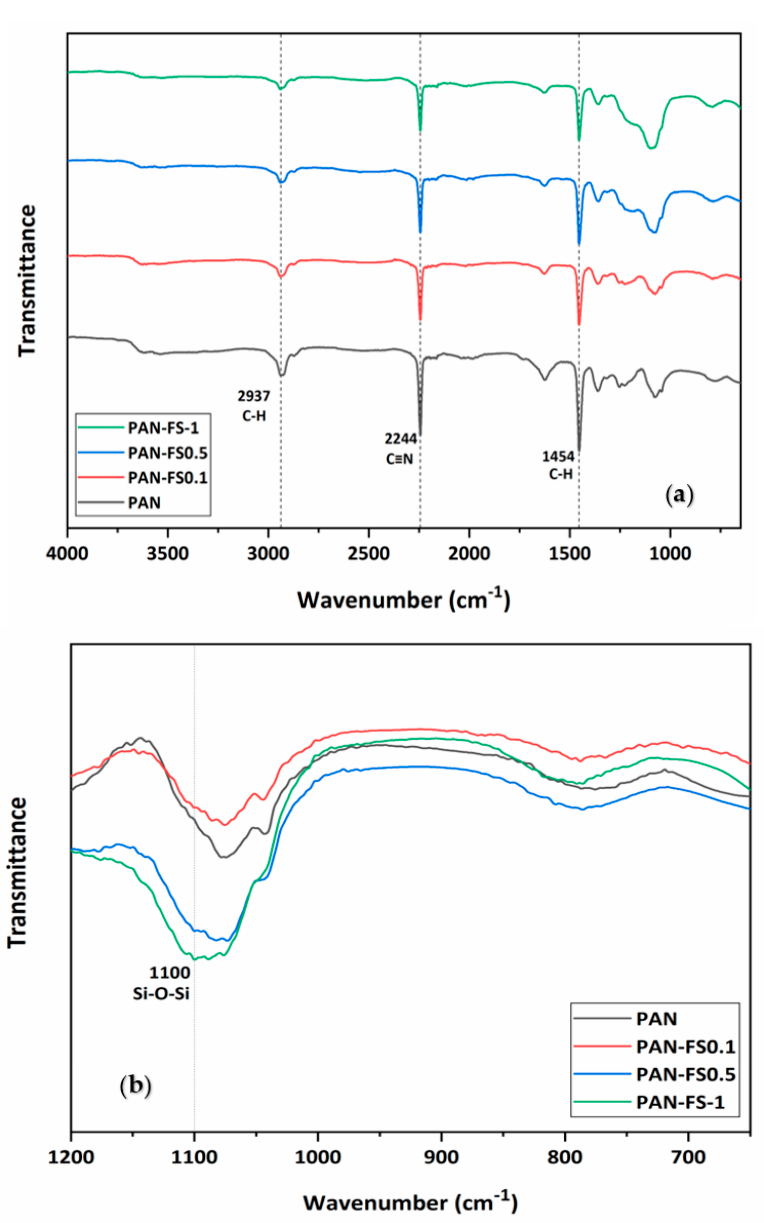
Figure 3. The FTIR spectra of the membranes are ( a ) 4000–650 cm − 1 and ( b ) 1200–650 cm − 1 wavenumber range.